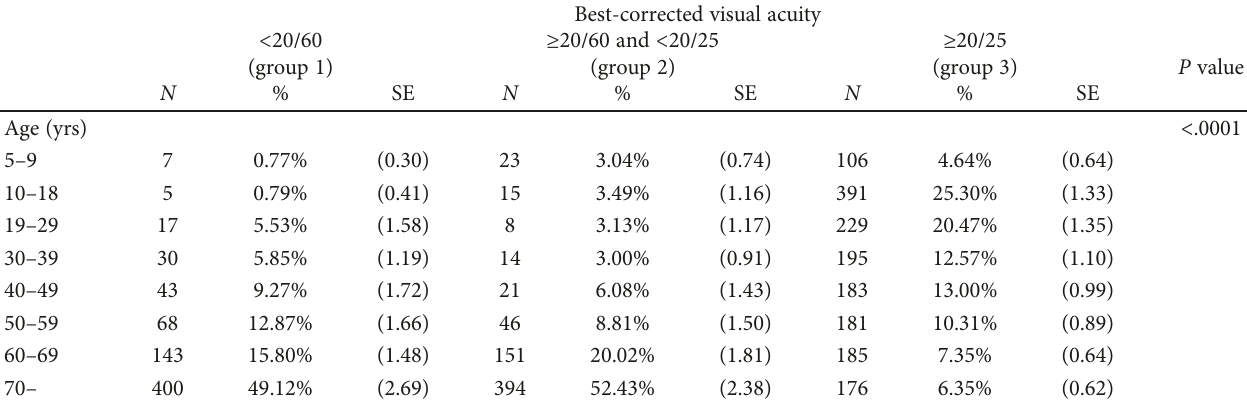
Table 3: Age distribution according to visual improvement after refractive correction.